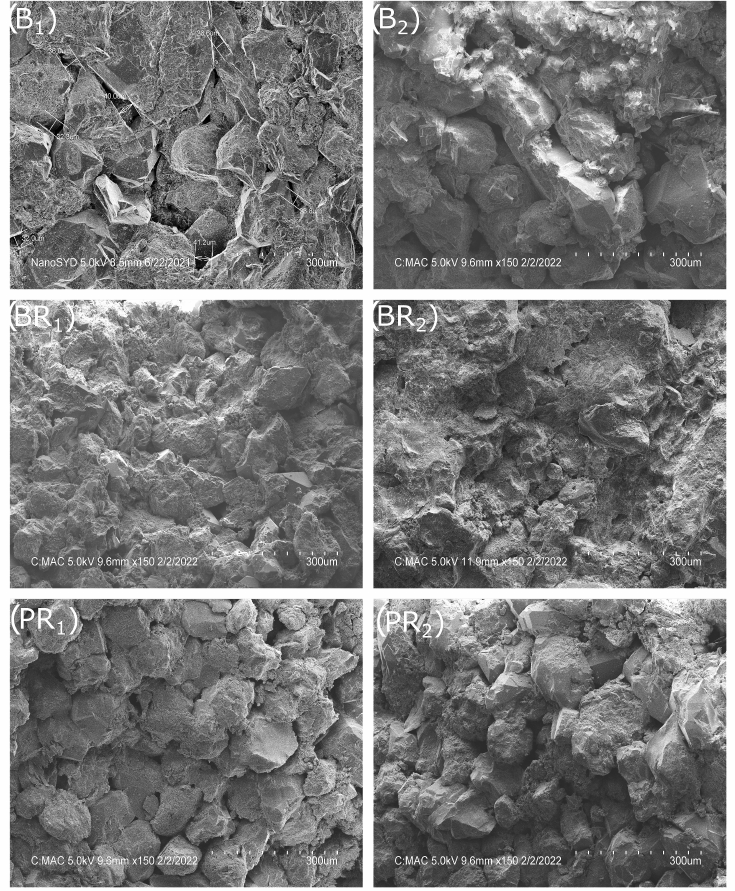
Figure 12. Scanning electron microscopy graphs for homogeneous and heterogeneous sandstone rocks. In this graph, B: Berea, BR: Bandera Brown, and PR: Parker